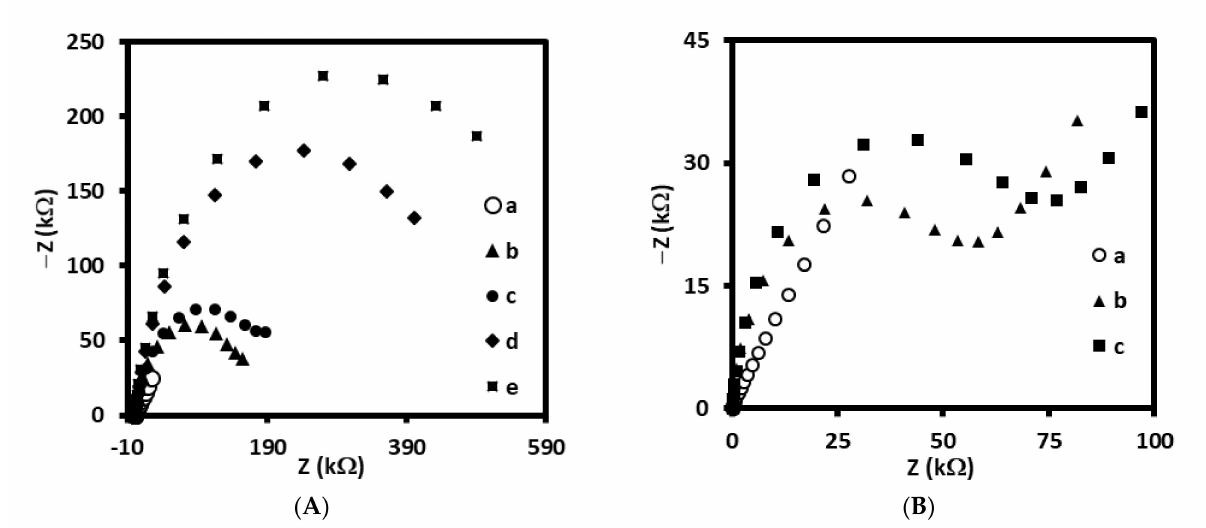
Figure 3. Impedance spectroscopy recorded for ( A ) immunosensor at different stages of fabrication: (a) bare gold elec- trode (Au), (b) Au/4-ATP, (c) Au/4-ATP/AbM-anti-apoB, (d) Au/4-ATP/AbM-anti-apoB/BSA, (e) Au/4-ATP/AbM- anti-apoB/BSA/LDL, and ( B ) aptasensor at different stages: (a) bare gold electrode (Au), (b) Au/LDL-Apt, 6MHol, (c) Au/LDL-Apt, 6MHol/LDL. Supporting electrolyte: PBS (pH 7.4) with 1 mM [Fe(CN) 6 ] 3 − /4 −